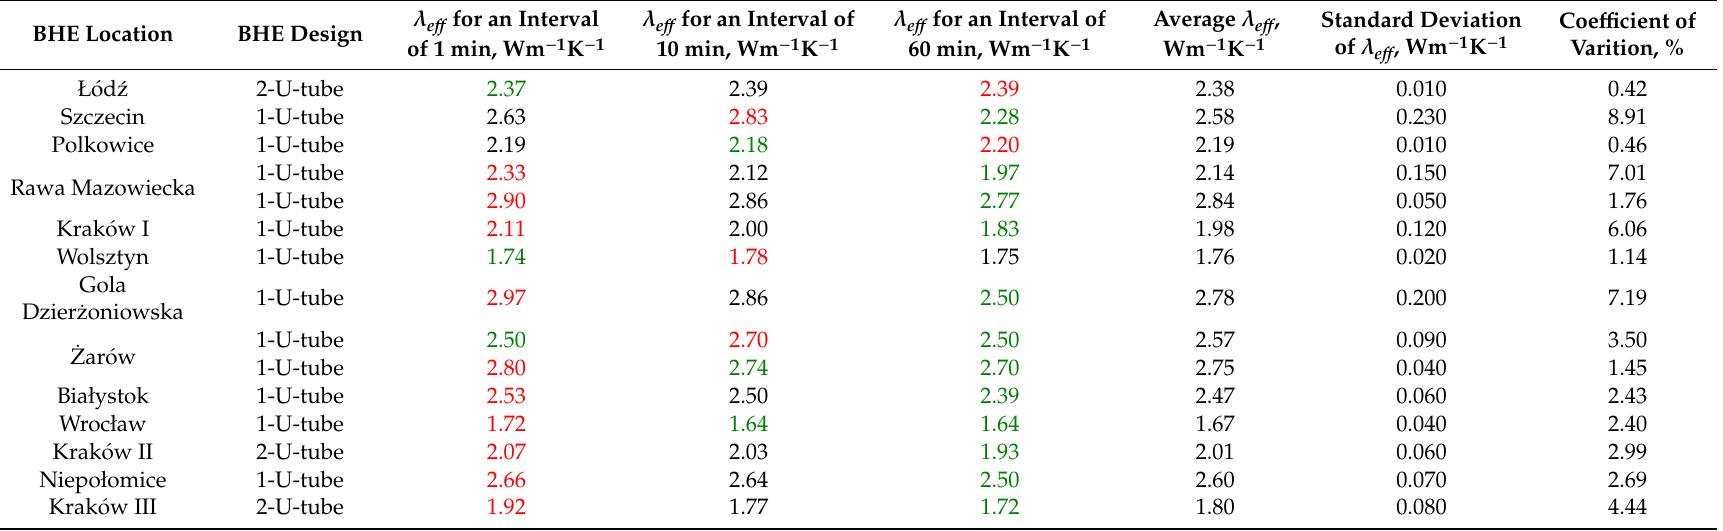
Table 9. Summary of the e ff ective thermal conductivity λ e ff of the borehole heat exchangers for which the thermal reaction test was performed (green—the lowest, red—the highest value of λ e ff